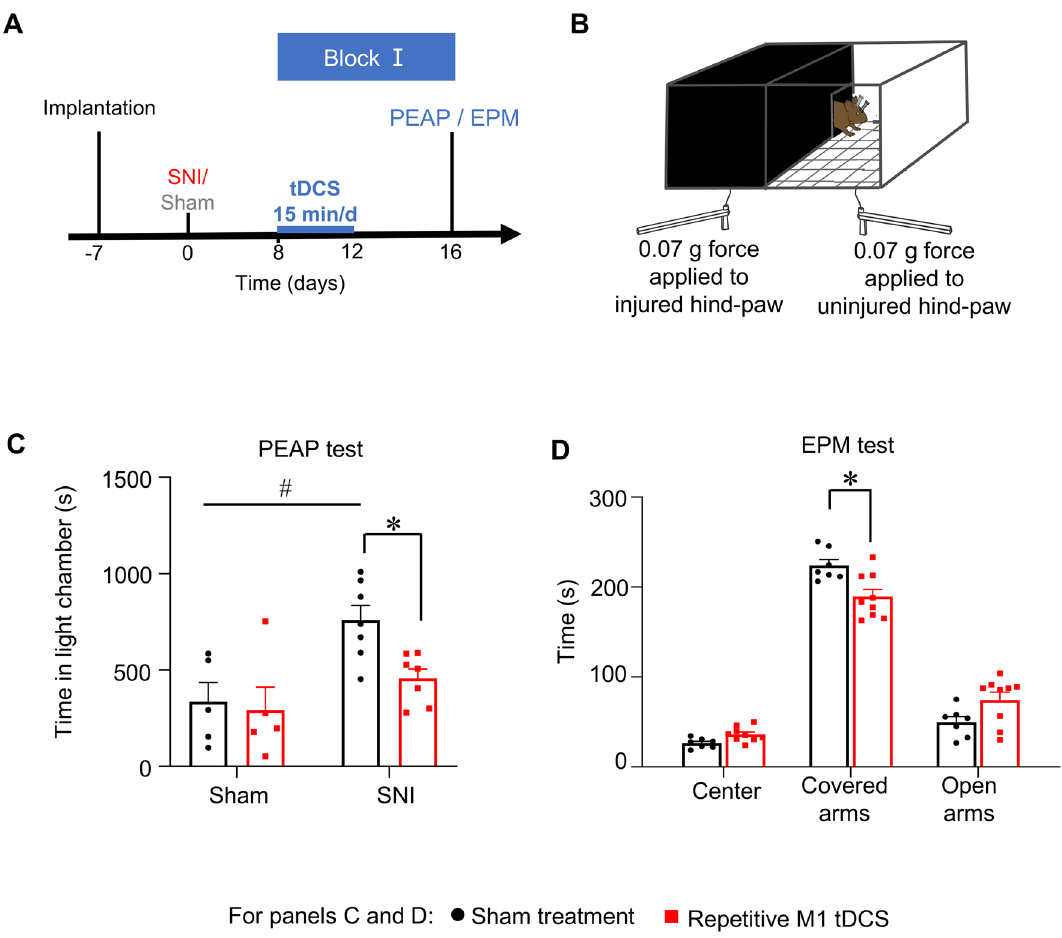
Figure 4. Impact of anodal M1 tDCS on behavioral parameters of neuropathic pain-associated aversion and anxiety. ( A ) Experimental scheme of implantation, nerve injury, stimulation protocol and behavioral analyses. ( B ) Scheme of the place escape avoidance paradigm (PEAP test), whereby light tactile von Frey force (0.07 g) is applied to the injured hind paw in the dark side of the chamber, while the uninjured hind paw of the mouse was given the same stimulus in the light side of the chamber in neuropathic mice; n = 5 mice each for the sham surgery groups and n = 7 mice each for the SNI groups ( C ) Quantitative summary of time spent in the light chamber (i.e. avoiding the dark chamber) in SNI and sham surgery groups of mice with M1 tDCS and sham stimulation treatment. ( D ) Analysis of anxiety, demonstrated as time spent in covered arms, in the elevated plus maze test in neuropathic mice with M1 tDCS and sham control treatment; n = 7 mice for the sham treatment group and n = 9 mice for repetitive M1 tDCS group. In all experiments, ANOVA for random measures was performed, followed by Tukey’s test for multiple comparisons, * indicates p < 0.05 as compared to the corresponding sham group. Data are represented as mean ±